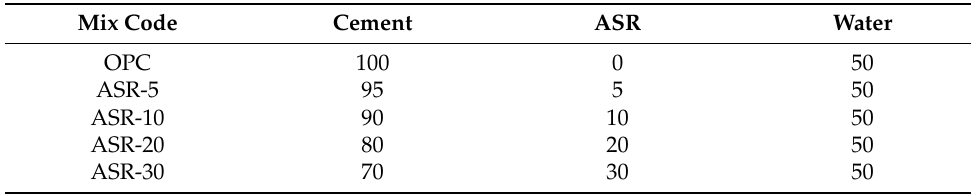
Table 2. Mix proportions of the pastes with different amounts of ASR